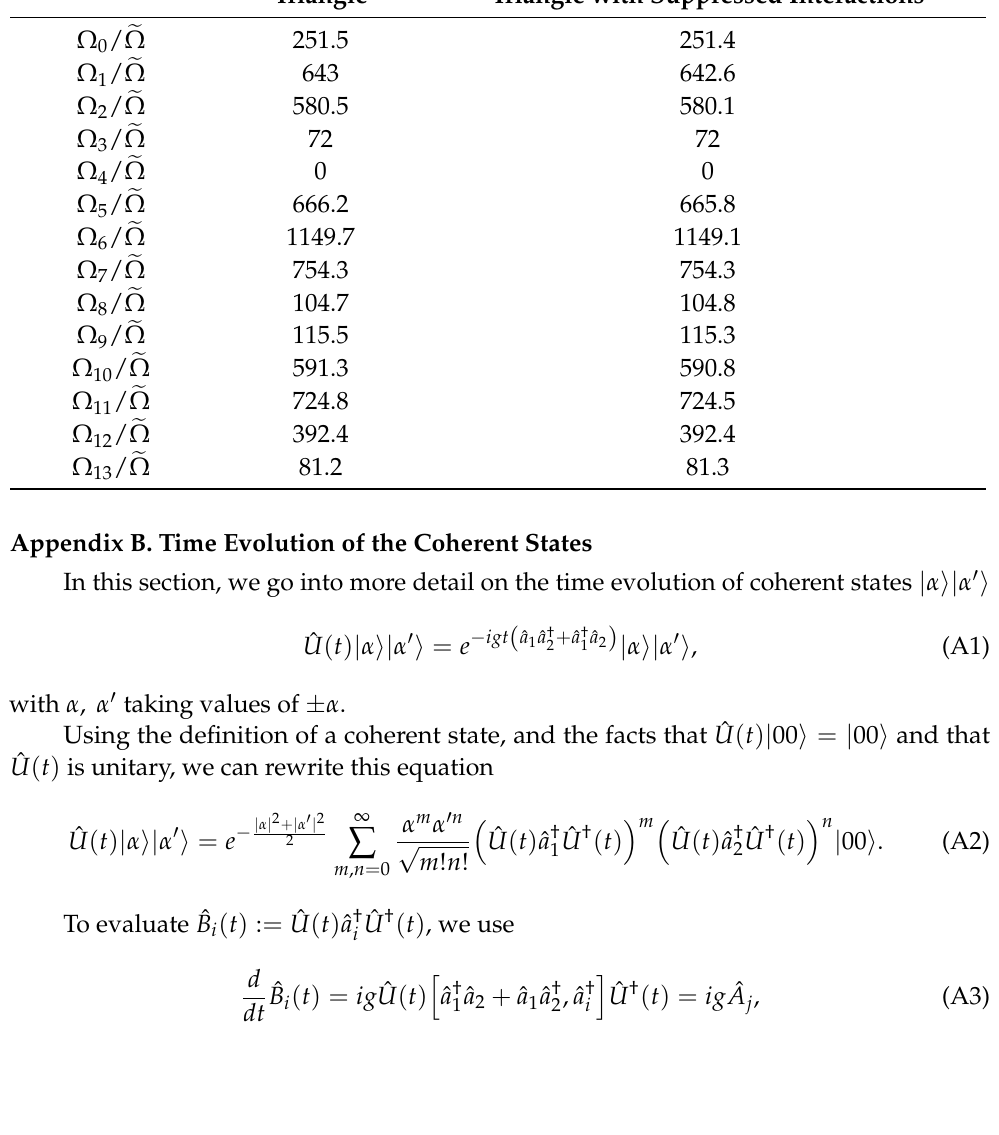
Table A1. Data values for Figure 4. Triangle Triangle with Suppressed